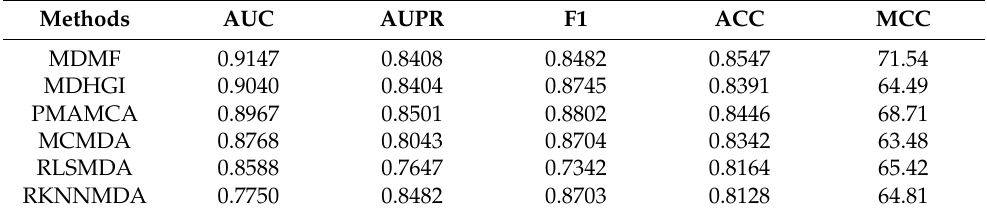
Figure 4. Performance comparisons between MDMF and six existing miRNA–disease association prediction models (PMAMCA, MDHGI, RKNNMDA, RWRMDA, MCMDA, and RLSMDA) in terms of AUCs based on local LOOCV. Table 2. Performance comparison of MDMF with other methods (global LOOCV). Various experi-